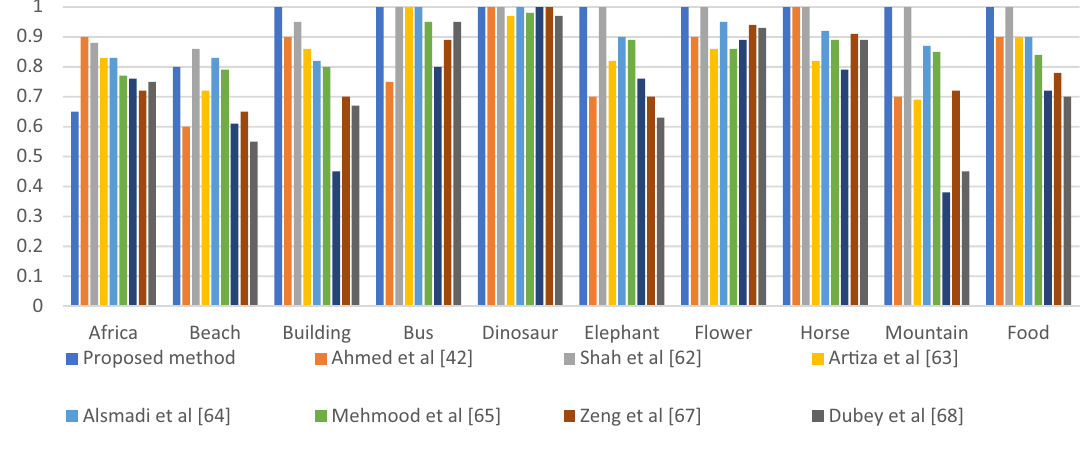
Fig. 20 Comparison of proposed method with state-of-the-art methods on Corel 1000